Question: What does this figure show? Answer in one sentence.
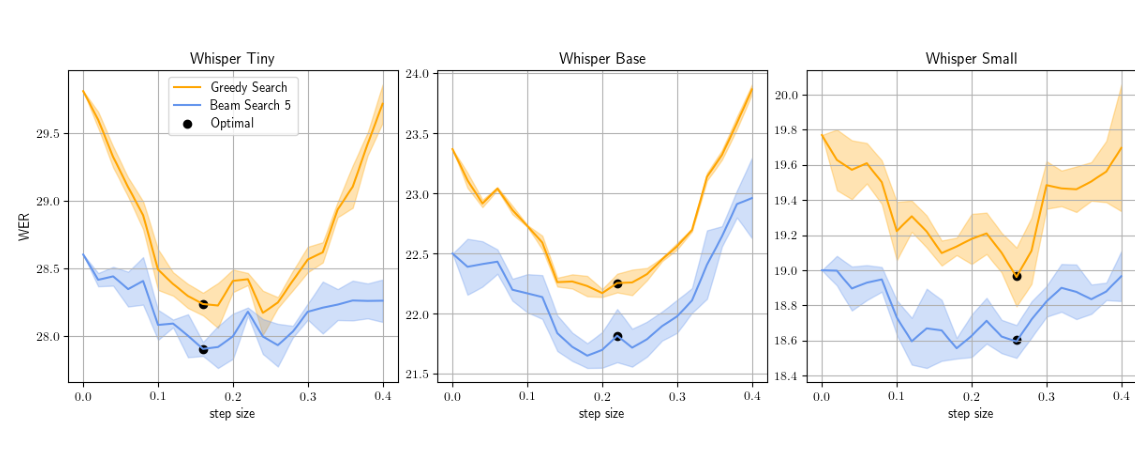
Answer: Modifying encoder outputs using the gradient of a NAP. This shows how the performance changes when we vary the step size α of the modification. The optimal point was decided based on the minimum WER found on the validation set.